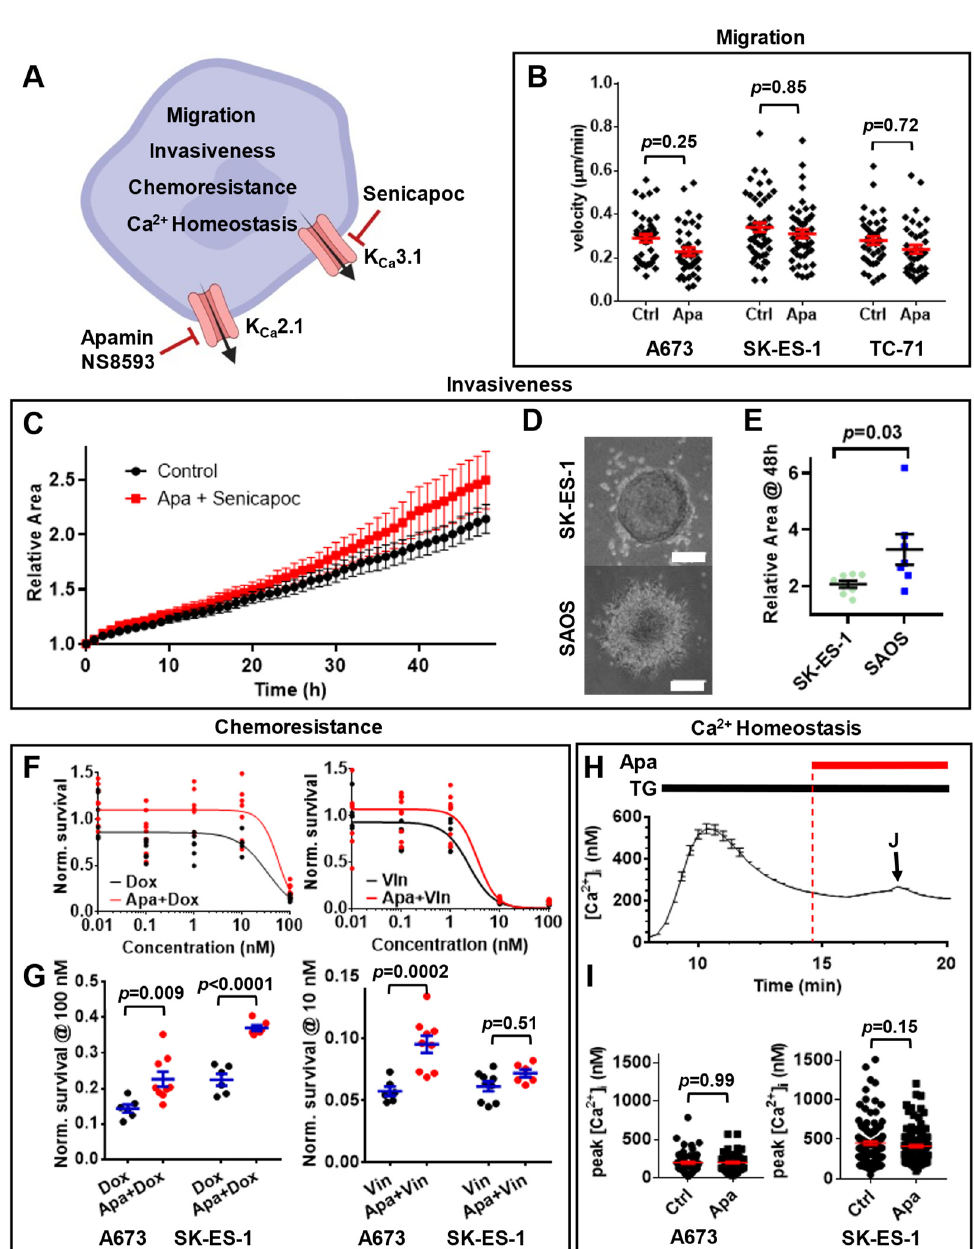
Figure 5. K Ca 2.1 is non-functional in Ewing sarcoma cells. ( A ) Illustration of investigated cell physiological processes assessed for K Ca channel dependence. Red arrows indicate pharmacological inhibitors of K Ca 2.1 and K Ca 3.1, respectively. ( B ) Cell migration velocities of EwS cells in each condition were derived from individual trajectories. Each dot represents the mean velocity of one cell. ( C ) Increase in the relative area of SK-ES-1 spheroids within 48 h. Spheroids were monitored under control conditions or treated with 100 nM apamin and 10 µM senicapoc N = 4, n = 8. ( D ) Representative images of matrix-embedded SK-ES-1 EwS cell spheroids and SAOS osteosarcoma cell spheroids acquired after 48 h. Scale bar = 200 µm. ( E ) Scatter plot indicates relative area of SK-ES-1 and SAOS spheroids. N = 4, n SK-ES-1 = 8, n SAOS = 7. ( F ) Survival after 72 h is depicted as a function of increasing concentration of doxorubicin (Dox, left) and vincristine (Vin, right), respectively. Data are derived from MTT assays. They were normalized to vehicle-treated cells (control). Additional treatment with 100 nM apamin is indicated in red. Data points were fitted with four-parameter dose–response curves (solid lines). ( G ) Scatter plots depict normalized cell survival at 100 nM Dox ( left ) and 10 nM Vin ( right ). EwS cell survival was calculated and normalized as detailed in ( F ). N = 3, n = 6. ( H ) Summary of intracellular Ca 2+ measurements of SK-ES-1 cells after eliciting SOCE with thapsigargin (TG). At t = 15 min (red dashed line), cells were additionally superfused with 100 nM apamin (Apa,